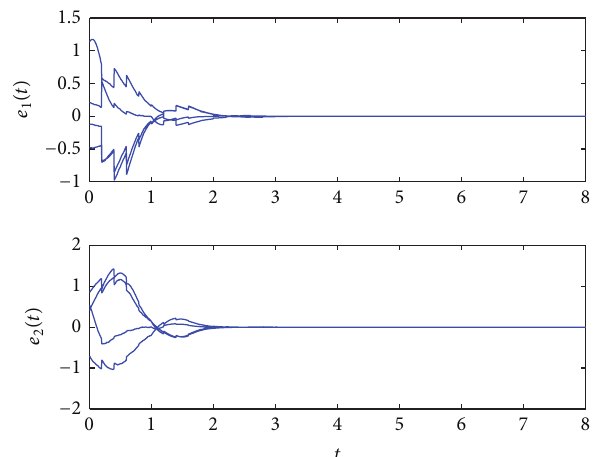
Figure 4: Evolution process of synchronization errors of two delayed Hopfield neural